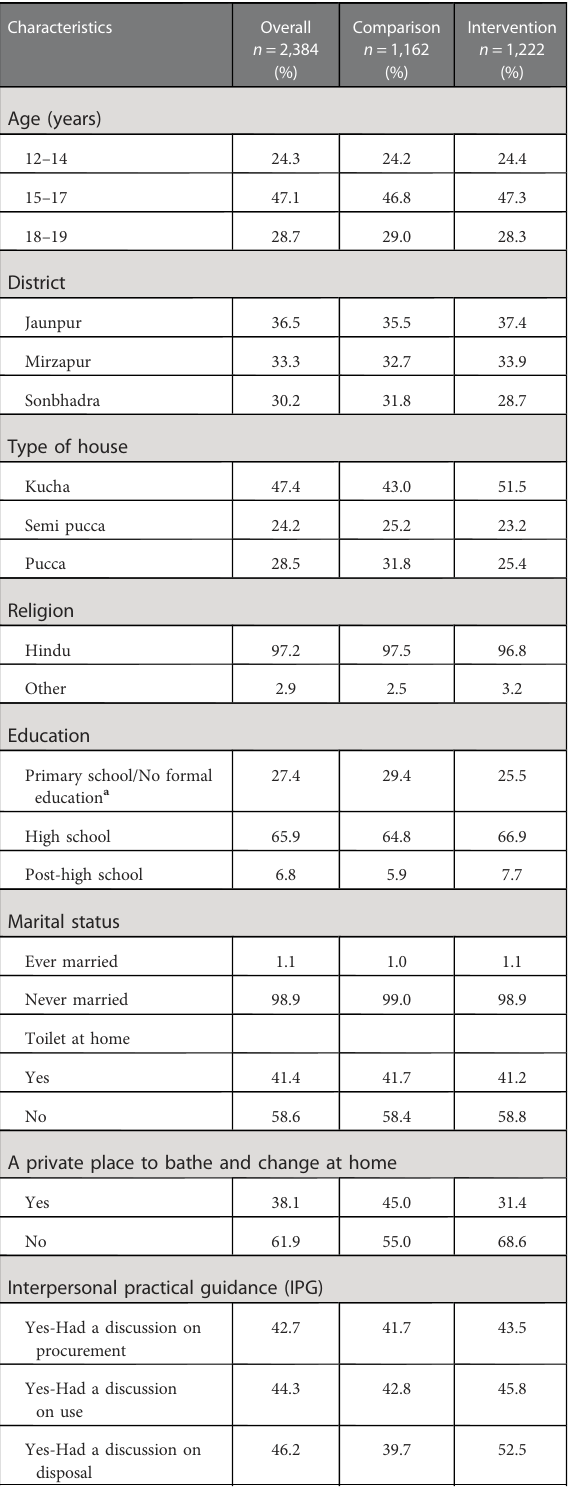
TABLE 2 Proportion of sociodemographic and socioeconomic characteristics among adolescent girls and their MHHM responses on procurement, use, and disposal